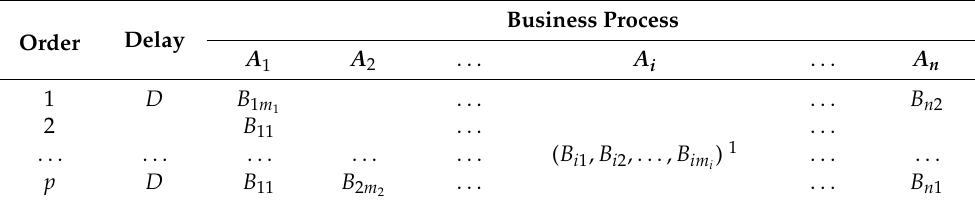
Table 1. Risk factors for orders.